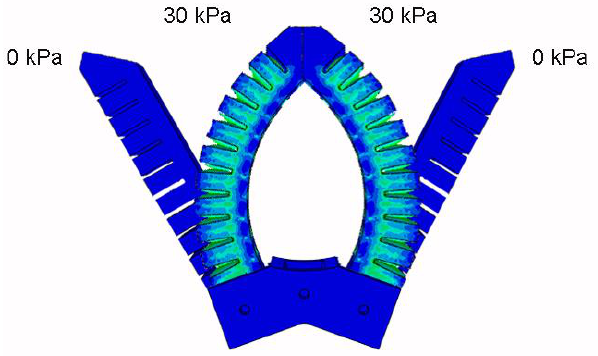
Figure 12. Fingertip contact diagram under air pressure 30 kPa.